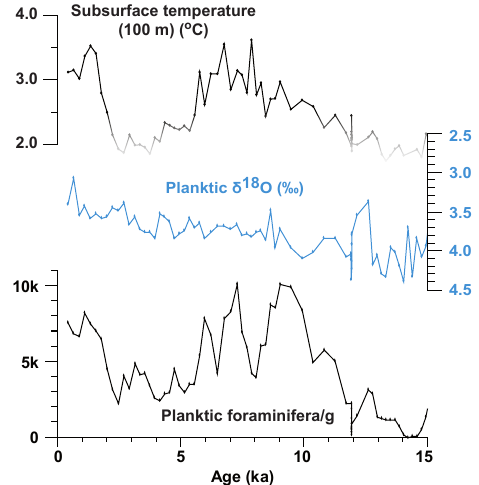
Fig. 7. Absolute subsurface temperatures calculated using the trans- fer function of Husum and Hald (2012) on planktic foraminifera from core PS1878 and planktic oxygen isotope and total plank- tic foraminiferal abundance records. Calculated temperatures below 2 ◦ C should be considered